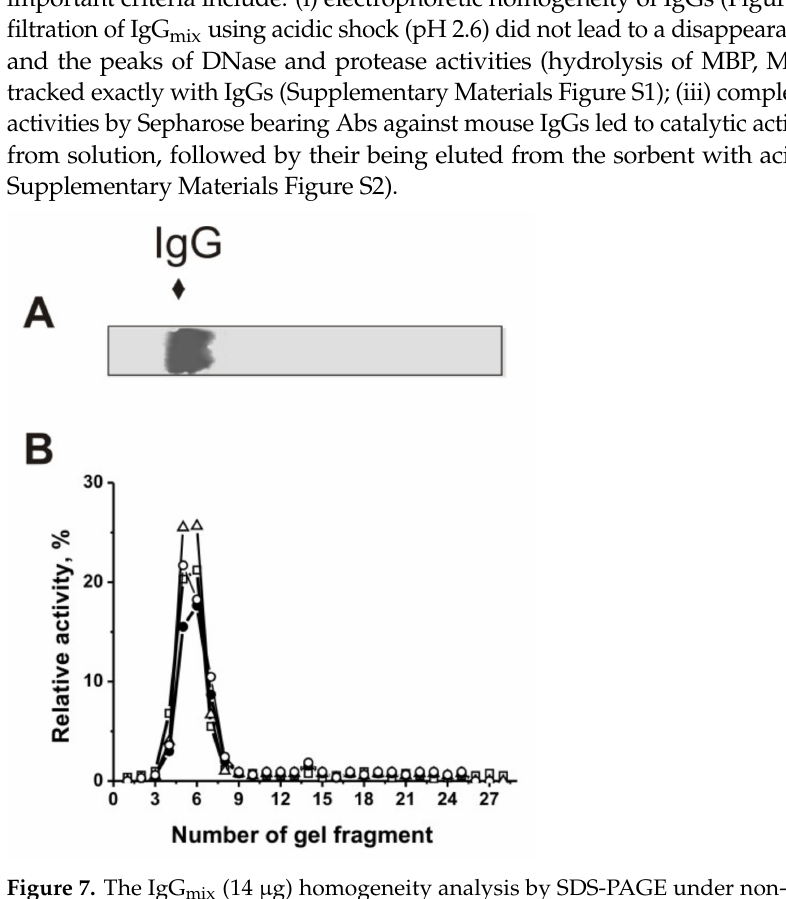
Figure 7. The IgG mix (14 µ g) homogeneity analysis by SDS-PAGE under non-reducing conditions in the absence of DTT ( A ); silver staining. Panel A demonstrates the position of IgGs. The relative activities (RA, %) in the hydrolysis of DNA ( ∆ ), MOG ( (cid:3) ), MBP ( • ), and histones (o) were estimated using eluates of gel fragments (2–3 mm) ( B ). After substrates incubation for 24 h with eluates, complete hydrolysis of all substrates was taken for 100% ( B ). The errors of the relative activities estimation from two independent experiments did not exceed